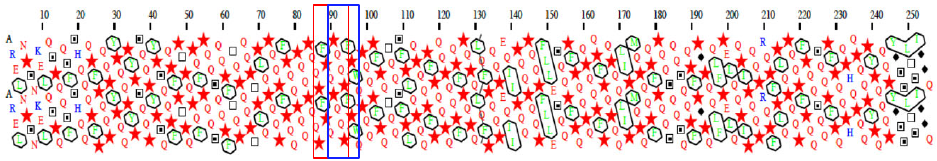
Figure 1. Amino acid sequences and HCA plots of representatives of the α -gliadin, γ -gliadin and ω -gliadin groups. CD peptides are highlighted in red and blue in the sequences, and are boxed in red and blue in the HCA plots.